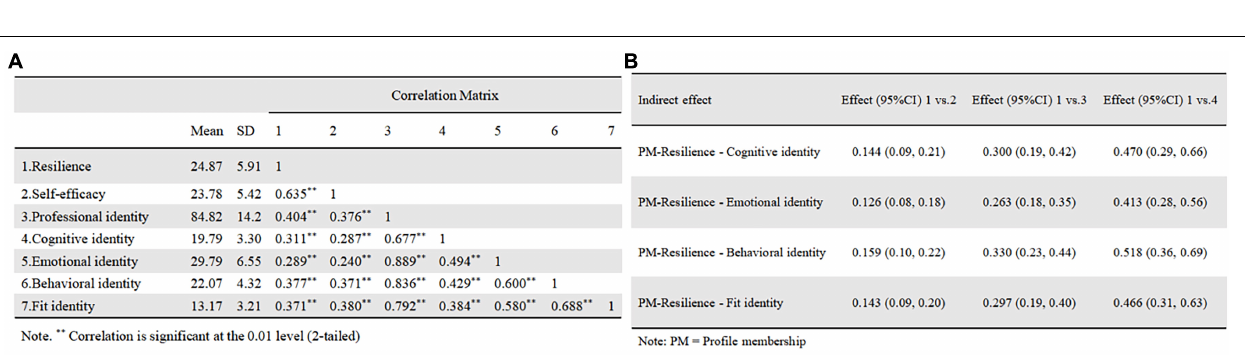
FIGURE 2 | (A) Fitting index and group size of latent profile analysis models. (B) Probability of scoring on GSES for 4 profiles of FNS’s self-efficacy. (C) Comparison of professional identity between the FNSs with different levels self-efficacy.